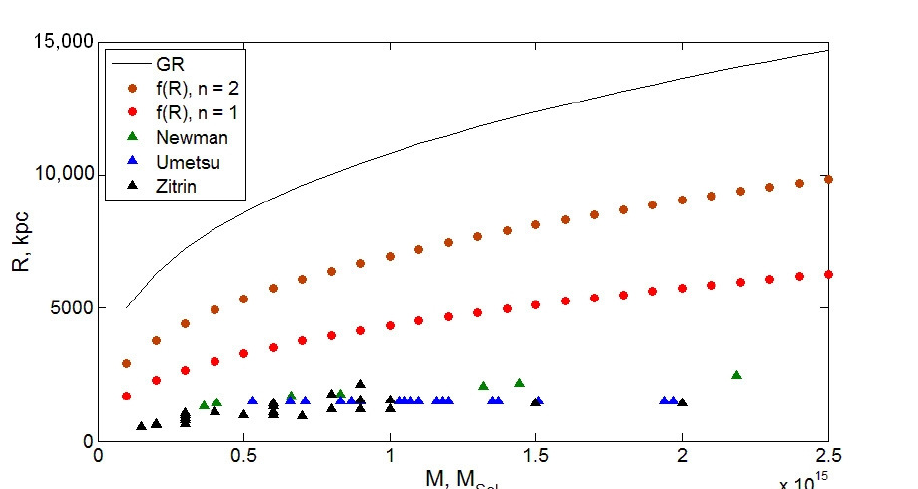
Figure 1. The theoretical and observational assumptions for the dependence of the turnaround radius value upon the mass of the galaxy cluster. The solid line corresponds to GR. Dots show these values for Starobinsky model with n = 1 and n = 2. Triangles show the real data from [32–34]. Reprinted/adapted with permission from Ref. [12]. 2017, J. Exp. Theor.